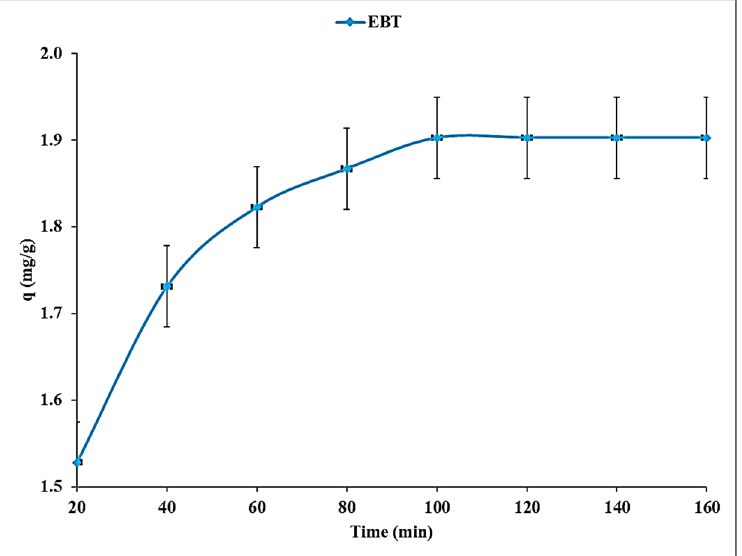
Figure 11. Effect of contact time of EBT dye adsorption by activated carbon of cannabis (T = 20 ± 1 °C, adsorbent dose 10 mg, C 0 = 10 mg.L − 1 , stirring speed = 150 rpm and pH = 7 ± 0.2).